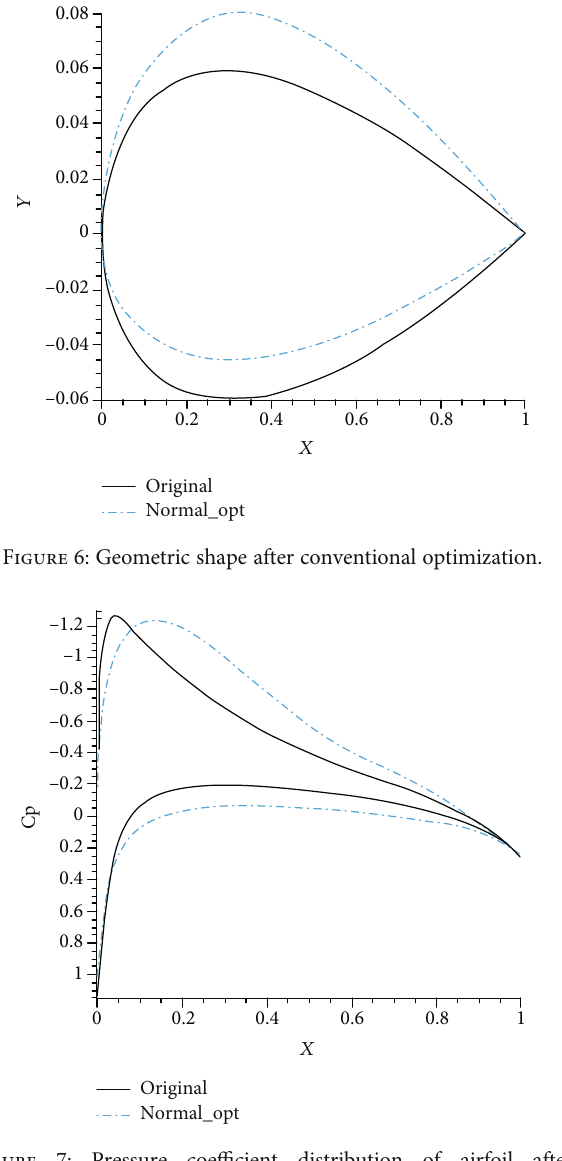
Figure 7: Pressure coe ffi cient distribution of airfoil after conventional optimization.